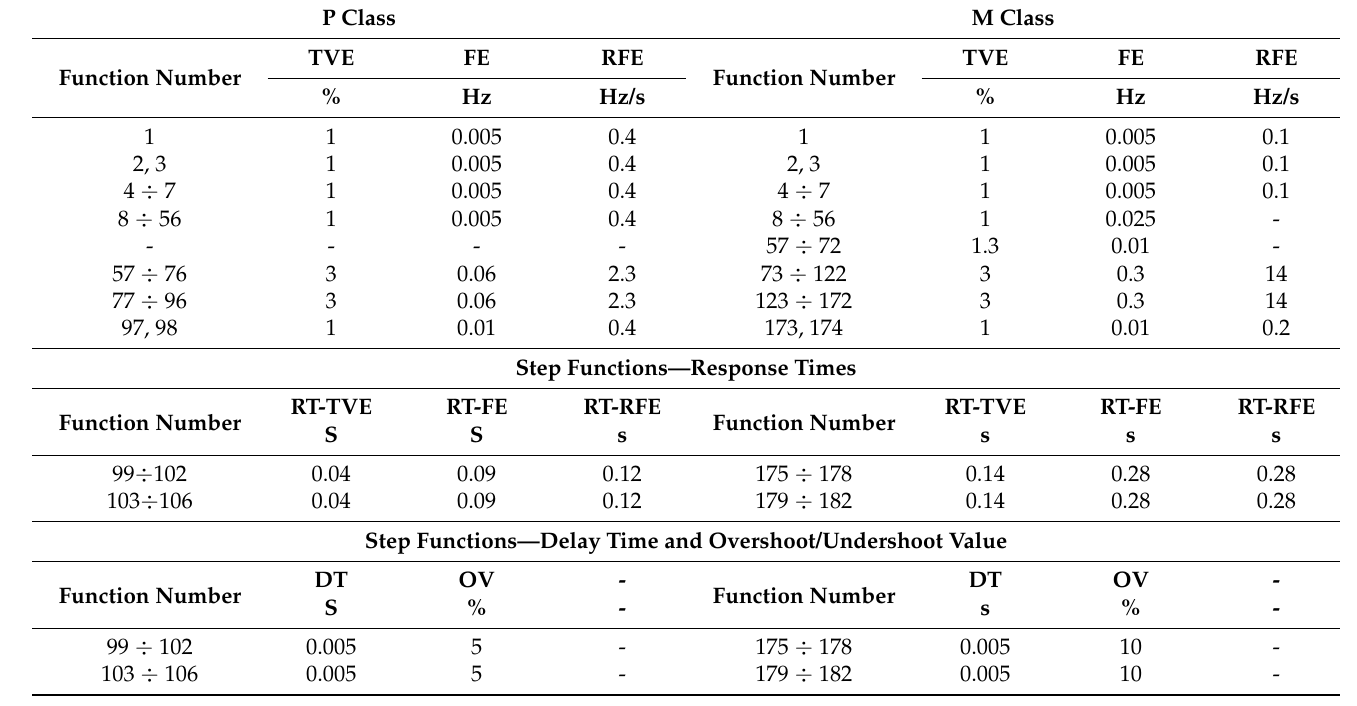
Table 1. Permissible measurement error values of synchrophasor